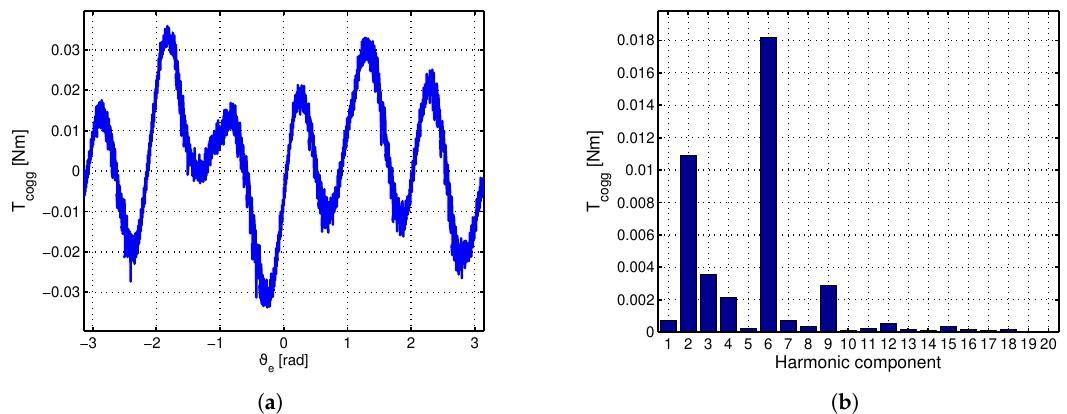
Figure 4. ( a ) measured cogging torque at no-load condition; ( b ) FFT analysis of measured cogging torque.